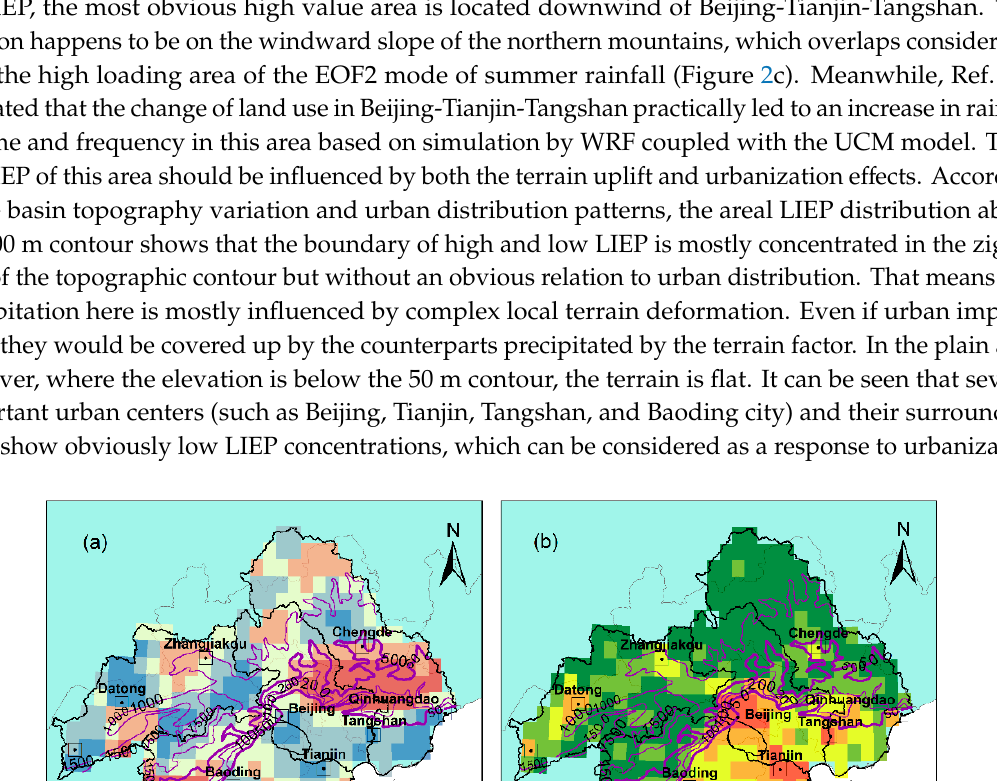
Figure 5. Areal multi ‐ year mean local induced enhancement of precipitation index (LIEP) ( a ) and urbanization level ( b ).